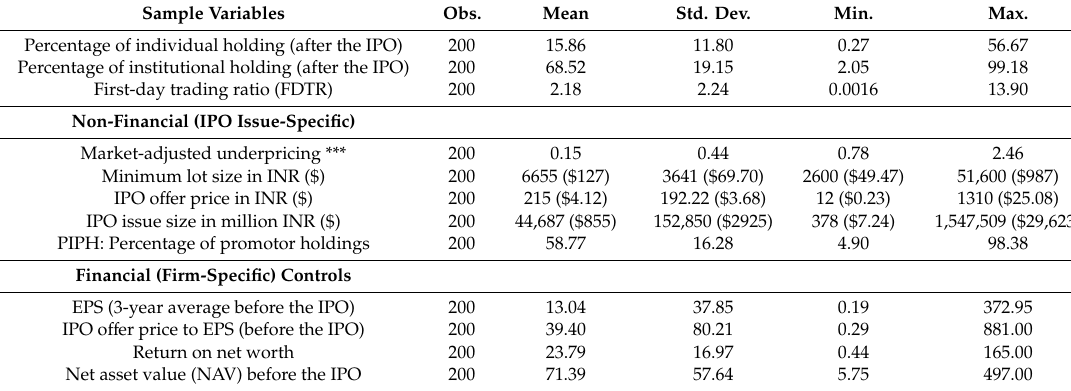
Table 2. Descriptive statistics for the sample variables. (INR and $ USD) The UDS $ conversation rate